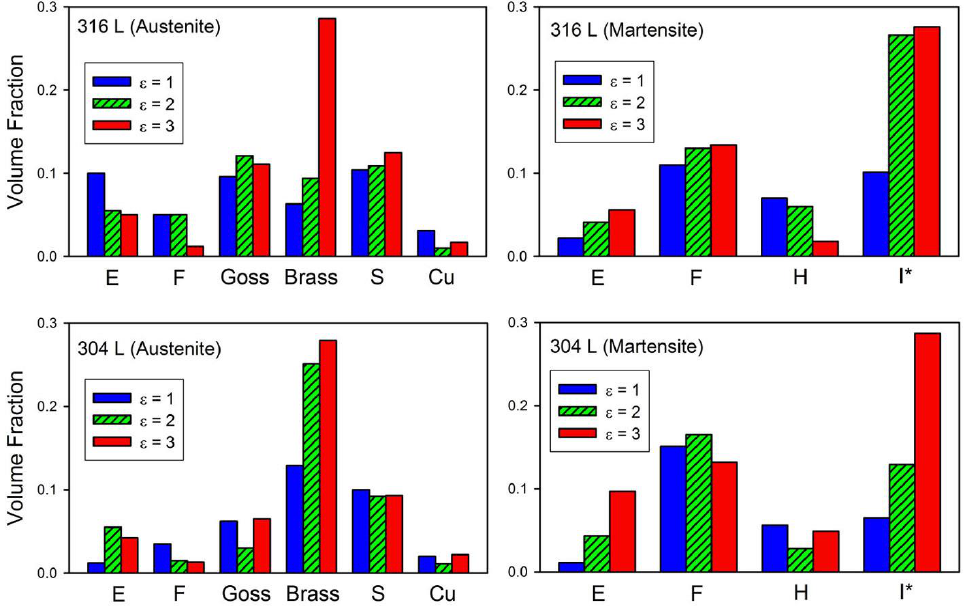
Figure 17. Fractions of the main texture components evolved in 316L and 304L stainless steels by cold rolling to different strains.